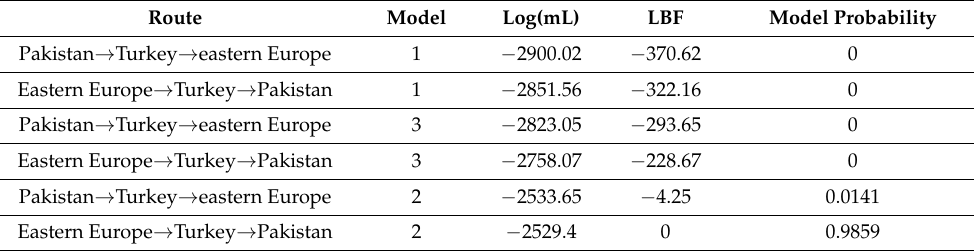
Table 3. Level two population movements Pakistan → Turkey → eastern Europe, eastern Europe → Turkey → Pakistan. The order of the models in each route was according to log marginal likelihood and the Bayes factor, the lowest to the highest. Log(mL), log marginal likelihood, LBF Bayes factor.